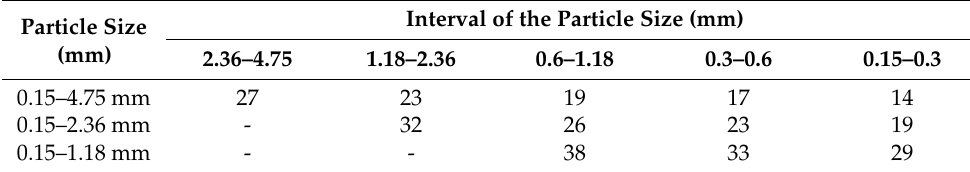
Table 2. The mass proportion of each interval of LWA (%).